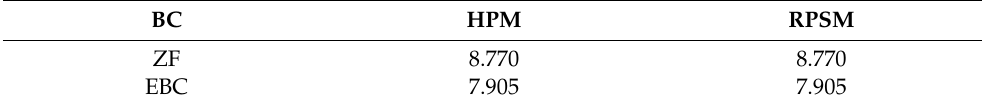
Table 17. Critical radius of four-group reactor.